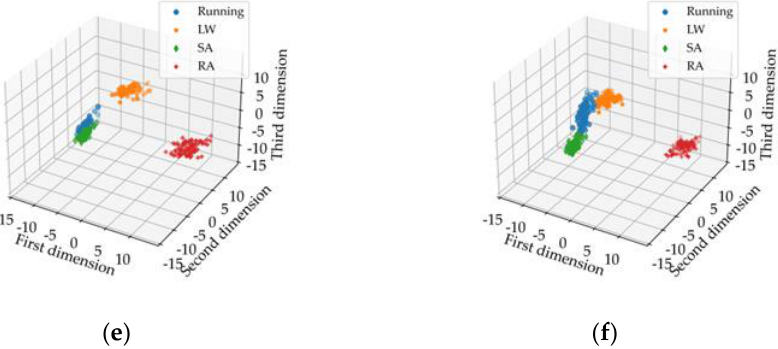
Figure 7. Visualization of feature extraction based on different methods and different types of sensor data. LW (level ground walking), SA (stair ascent), RA (ramp ascent). ( a ) represent the features extracted by using Dual Stream CNN-ReliefF based on the fusion of EMG and IMU data; ( b – d ) represent the features extracted by using Single Stream CNN based on a single EMG, a single IMU and the fusion of the two data, respectively; ( e , f ) represent the features with better visual effects extracted by manual design based on a single EMG, a single IMU and the fusion of the two data, respectively.